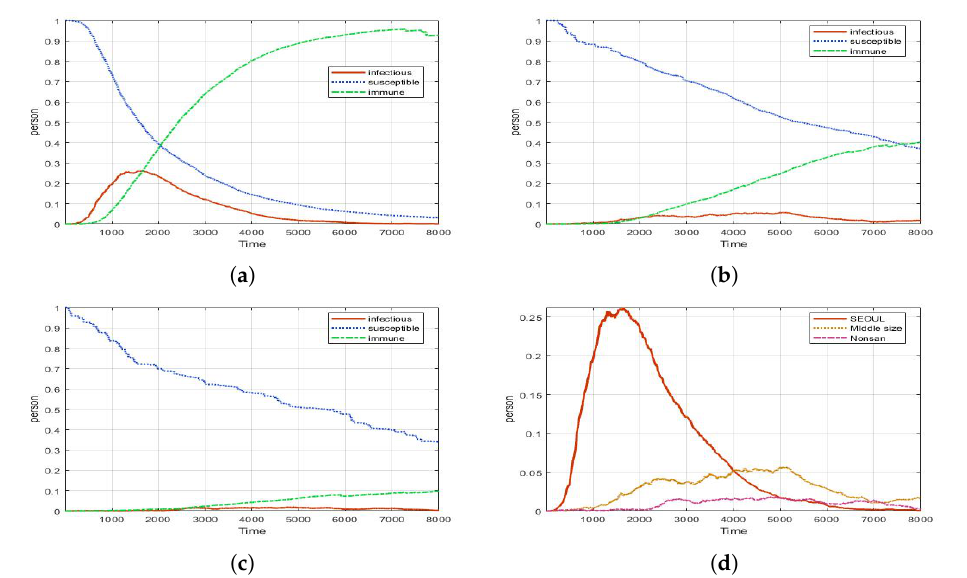
Figure 9. Experimental results for PCR test (with different density of population): ( a ) Seoul (peak: 0.26, 1668 ticks); ( b ) Metro city (peak: 0.05, 5070 ticks); ( c ) Country (peak: 0.01, 4886 ticks); ( d ) Infectious for all areas.